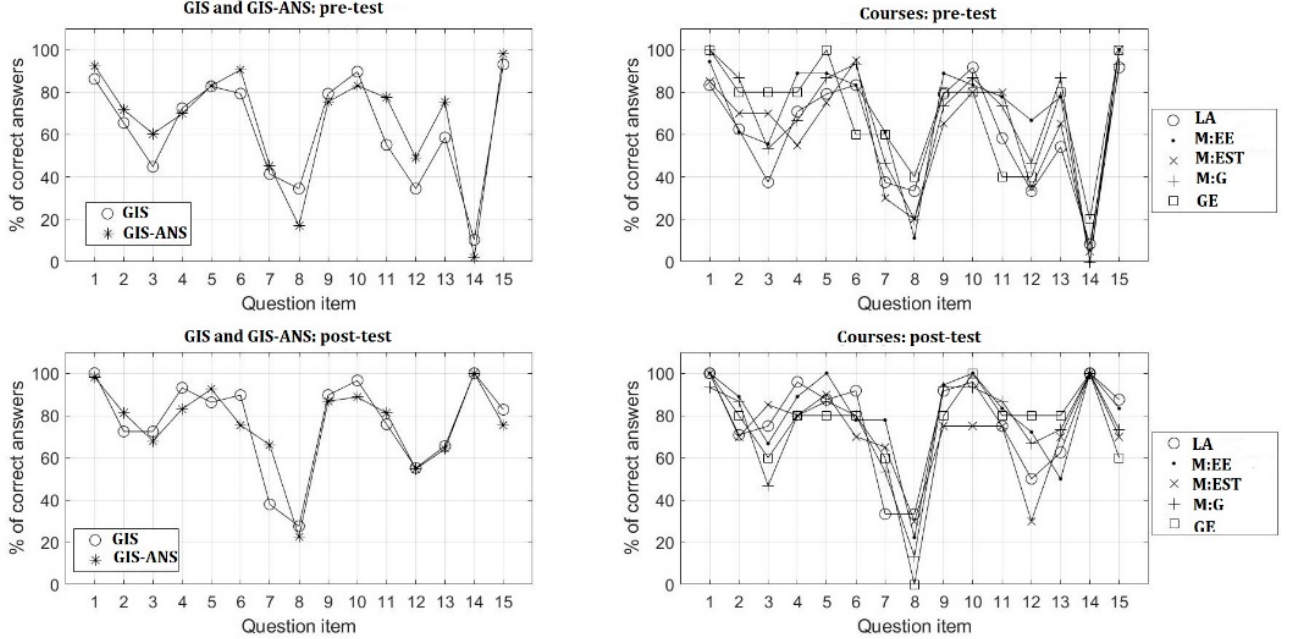
ISPRS Int. J. Geo-Inf. 2022 , 11 , 417 Figure 1. Percentages of students with correct answers by Curricular Units ( first row ) and courses ( second row ) in the pre- and post-test.